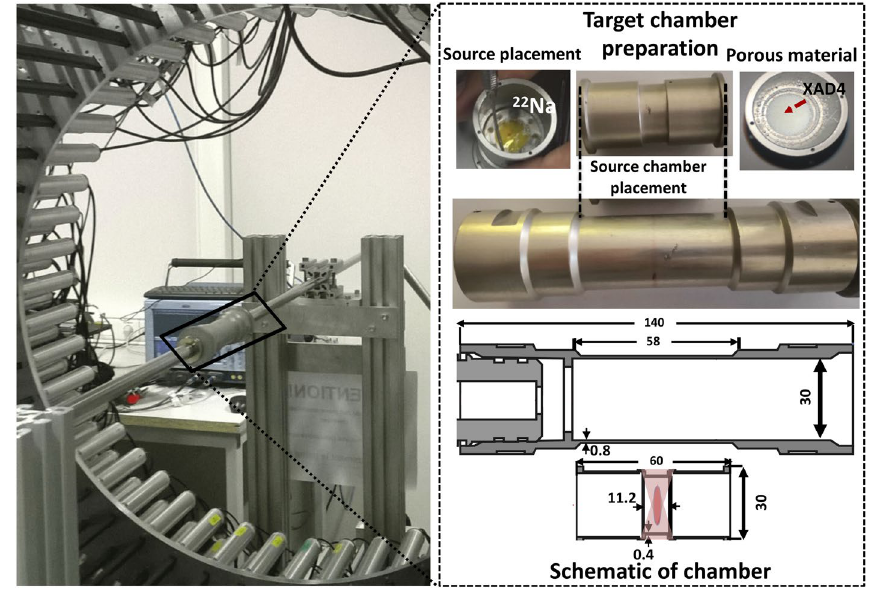
Fig. 4 Left panel shows the experimental setup. The source chamber was aligned in the center of the J‑PET tomograph. The upper part of the right panel shows the zoomed version of the source chamber and its preparation. The bottom part describes the schematic of the target chamber with dimensions (in mm). The red color in the center of the small cylinder represents the position of the